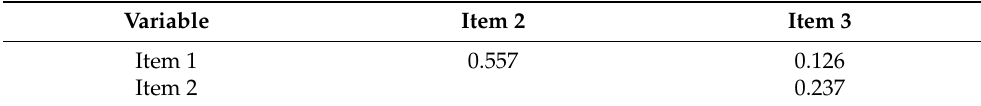
Table 2. Inter-item correlations of the items of the Croatian GSLTPAQ (N = 823).